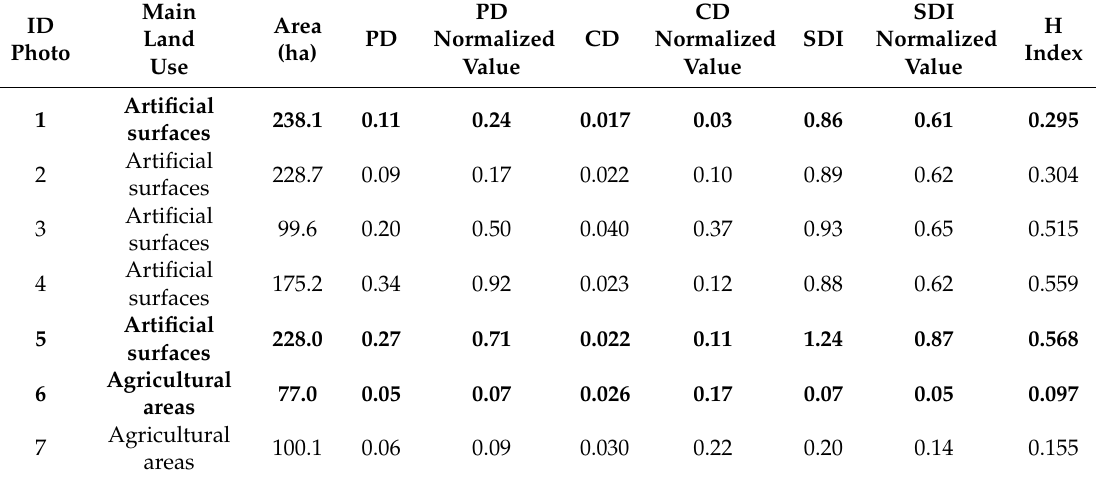
Table A1. Results of the characterization of the 15 viewsheds in relation to main land-use and heterogeneity level. In bold, the six selected viewsheds. Patch density (PD), land-use class density (CD) and Shannon’s diversity index (SDI) and their normalized values, and index of landscape heterogeneity (H index